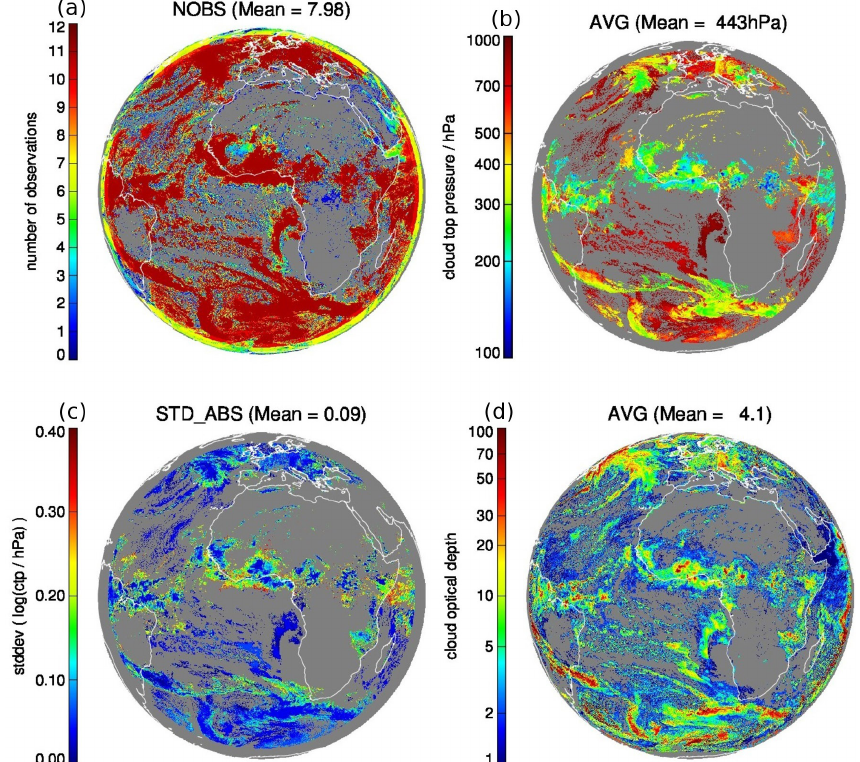
Figure 2. Multi-algorithm ensemble statistics. Panel (a) displays the number of algorithms that provide a CTP value. Panel (b) shows the multi-algorithm average of the cloud top pressure (CTP). Panel (c) shows the standard deviation of the log 10 (CTP). In Panel (b) and (c) , values are shown for areas only, for which all retrievals detect clouds (common mask) to eliminate effects of different sample sizes. Panel (d) shows the multi-algorithm average of the cloud optical depth (not limited to the common mask). All images are for 13 June 2008,